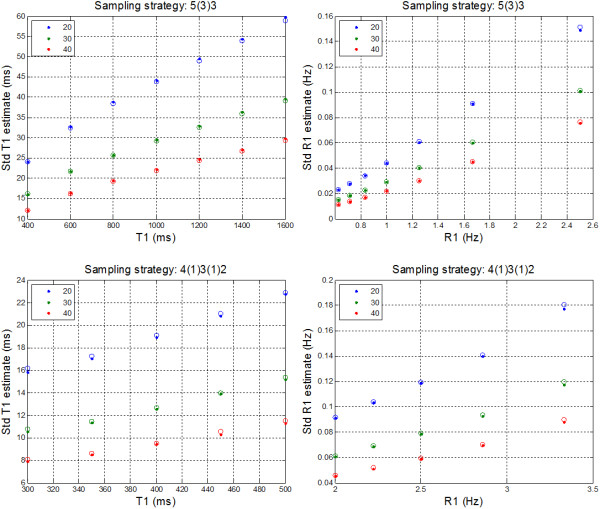
Measured (dots) vs calculated (circles) standard deviation of T1 vs T1 (left column) for various image SNRs for 2 sampling strategies, 5(3)3 and 4(1)3(1)2, from Monte-Carlo simulation with 65,536 trials, and corresponding standard deviations for R1 = 1/T1 (right column).